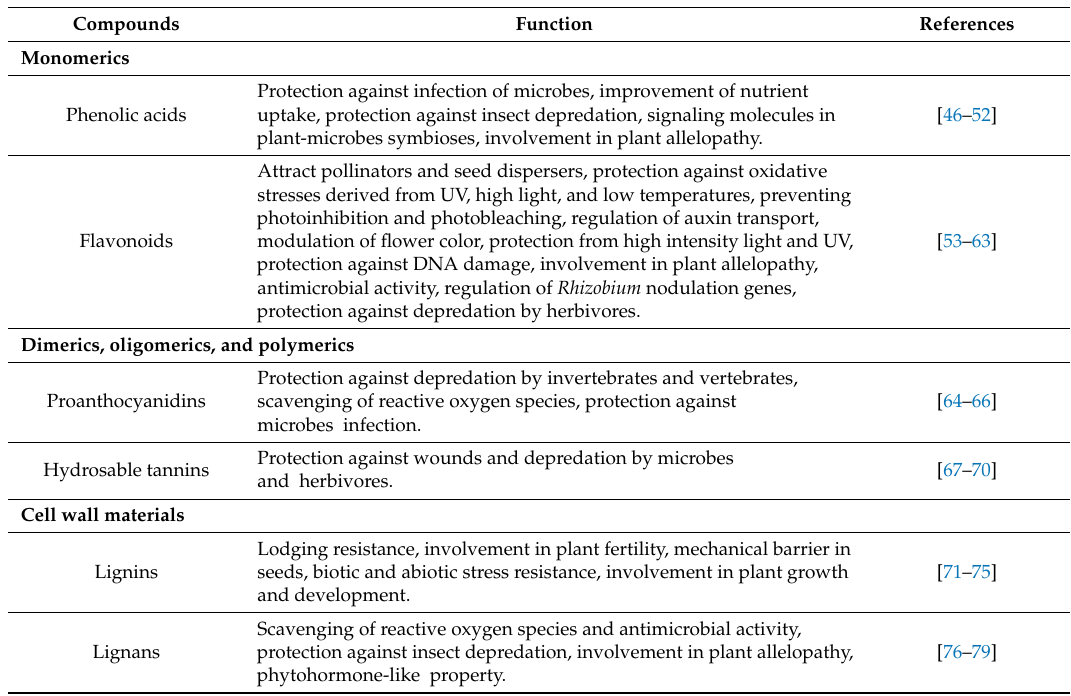
Table 1. Role of phenolic compounds in